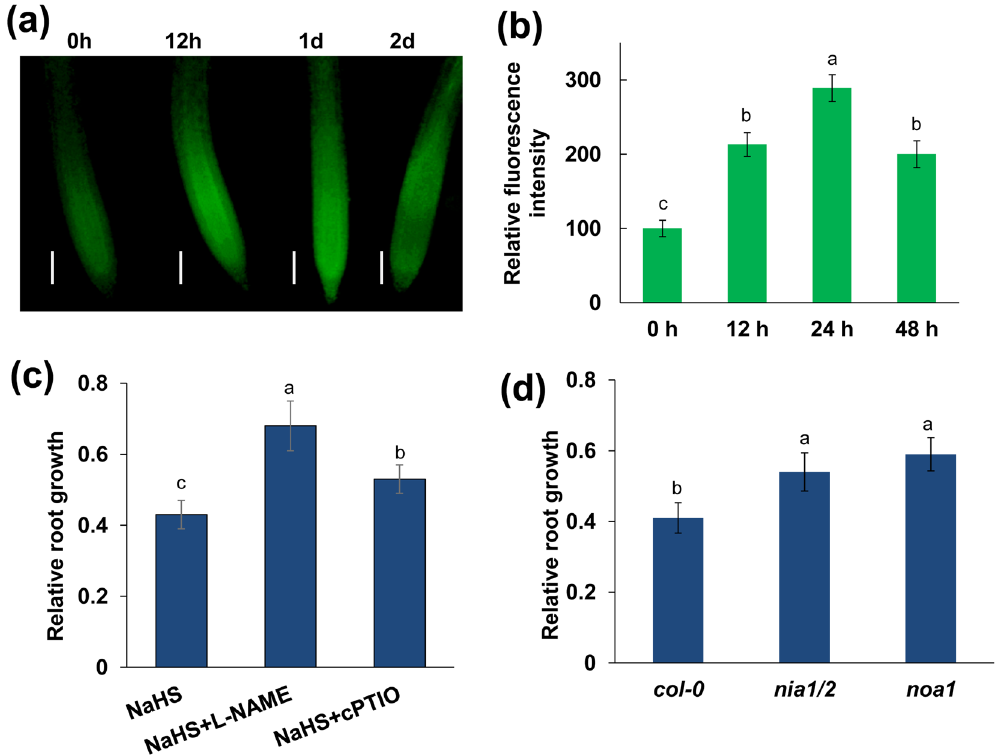
Figure 3. NO is involved in the NaHS-mediated inhibition of PR growth. ( a , b ) Detection of NO production in the roots of 5-d-old wild-type seedlings exposed to 500 μ M NaHS for periods of up to 2 d using the NO-specific fluorescence probe DAF-2 DA ( a ) and quantification of NO-specific fluorescence intensities ( b ) in plants treated as described in ( a ). The fluorescence intensity of the untreated roots was set to 100. Bars, 100 μ m. n = 30. ( c ) Relative root growth of Col - 0 seedlings treated with 500 μ M NaHS in the presence or absence of 500 μ M L-NAME and 200 μ M cPTIO for 2 d compared with untreated seedlings. ( d ) Relative root growth of Col - 0 , nia1 / 2 , and noa1 seedlings treated with 500 μ M NaHS for 2 d compared with untreated seedlings. n = 45. Error bars represent ± SD. Different letters indicate significantly different values (P < 0.05 by Tukey’s